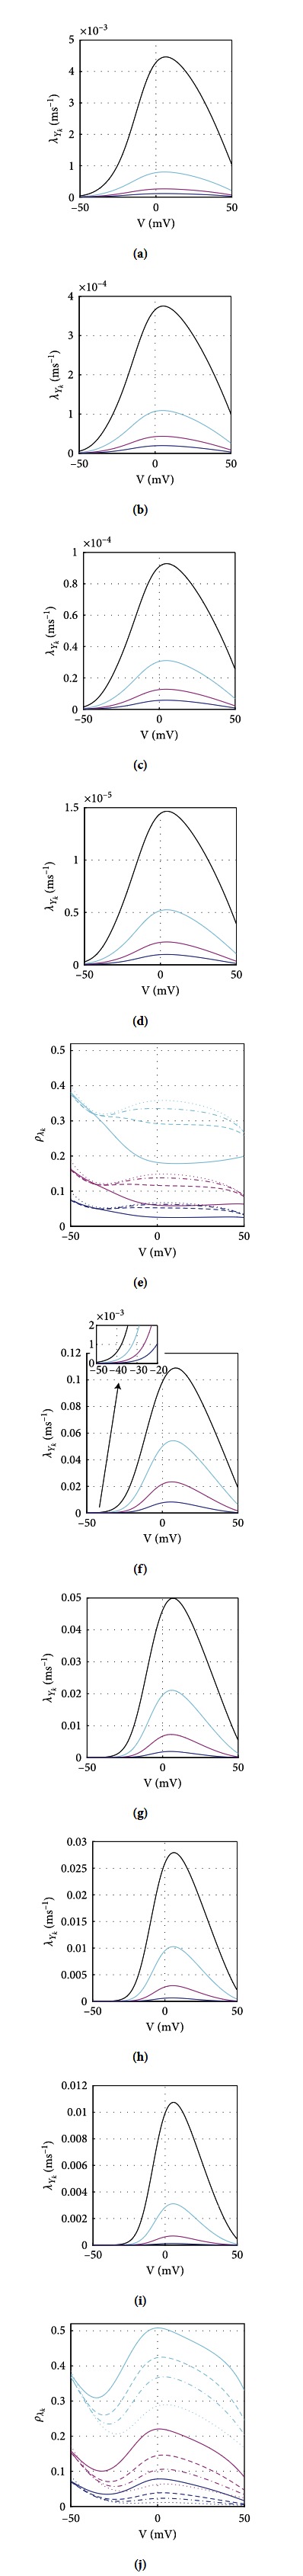
Expected exocytosis rate for single granule coupled with k (inactivating or non-inactivating) CaVs. (a–d) and (f–i) Expected exocytosis rate λ
Yk for the granule at fixed distance r
G from k (k=1 (blue curves), k=2 (magenta), k=4 (cyan), and k=8 (black)) inactivating/not-inactivating CaVs: r
G=10 nm (a/f), 20 nm (b/g), 30 nm (c/h), and 50 nm (d/i). The insert in (f) is a zoom on the lower, left part of the figure for comparison with (a). (e) and (j) Relative rate ρ
λk obtained from the granule coupled with k inactivating/not-inactivating CaVs (e/j), for k=1 (blue), k=2 (magenta), and k=4 (cyan) and compared to the case with n=8 CaVs. The different type of line corresponds to ρ
λk computed at fixed distance: r
G=10 nm (solid line), r
G=20 nm (dashed), r
G=30 nm (dash-dotted), and r
G=50 nm (dotted).